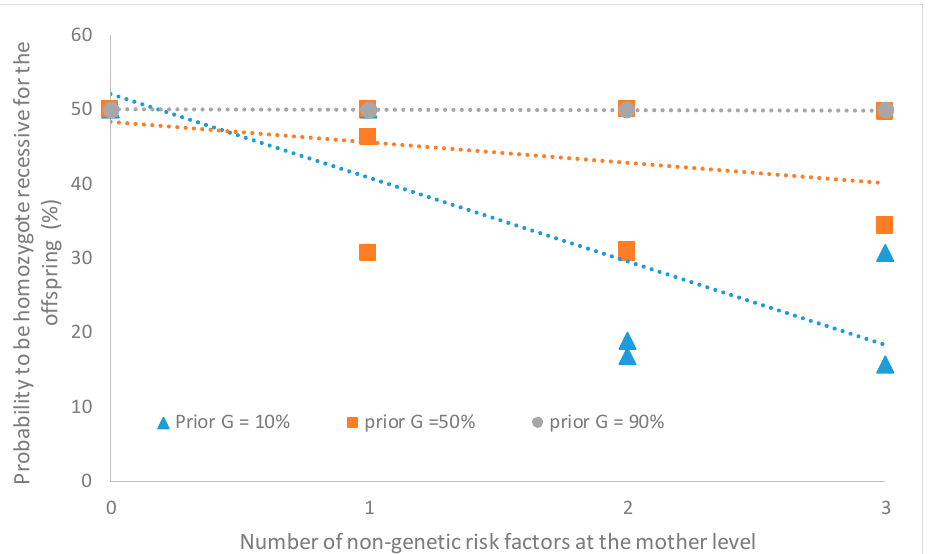
Figure 3. Probability to be homozygous for the deleterious allele for the offspring as a function of the number of non-genetic risk factors of degenerative myelopathy observed at the mother level.